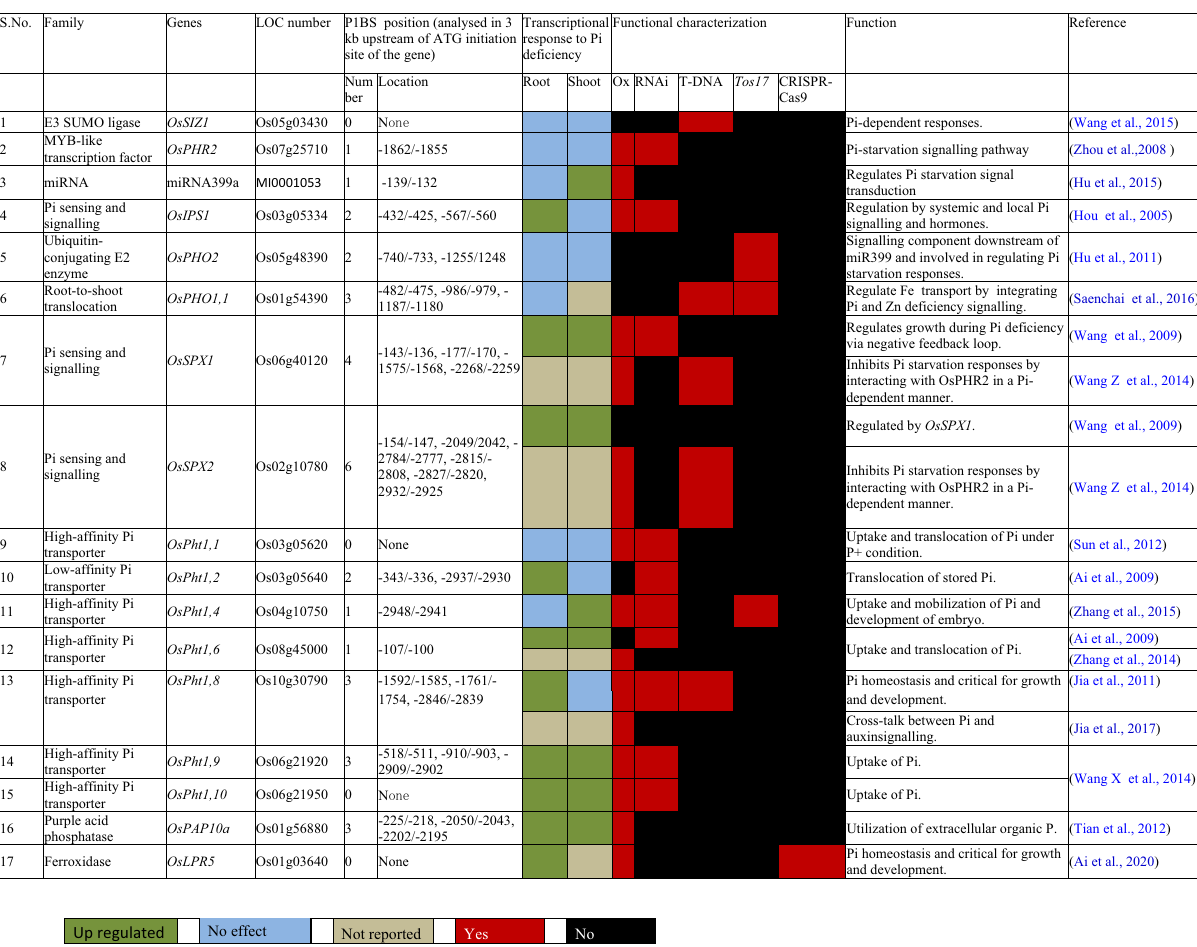
Table 2. Functionally characterized genes involved in the maintenance of Pi homeostasis in rice.